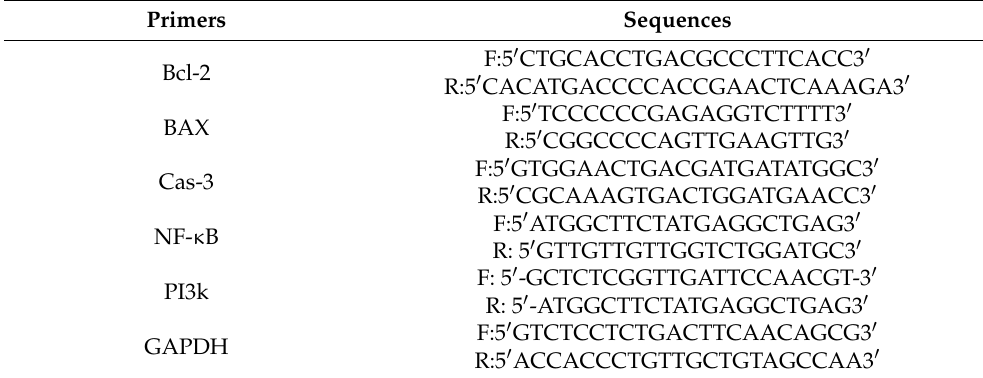
Table 1. Primer sequences used for